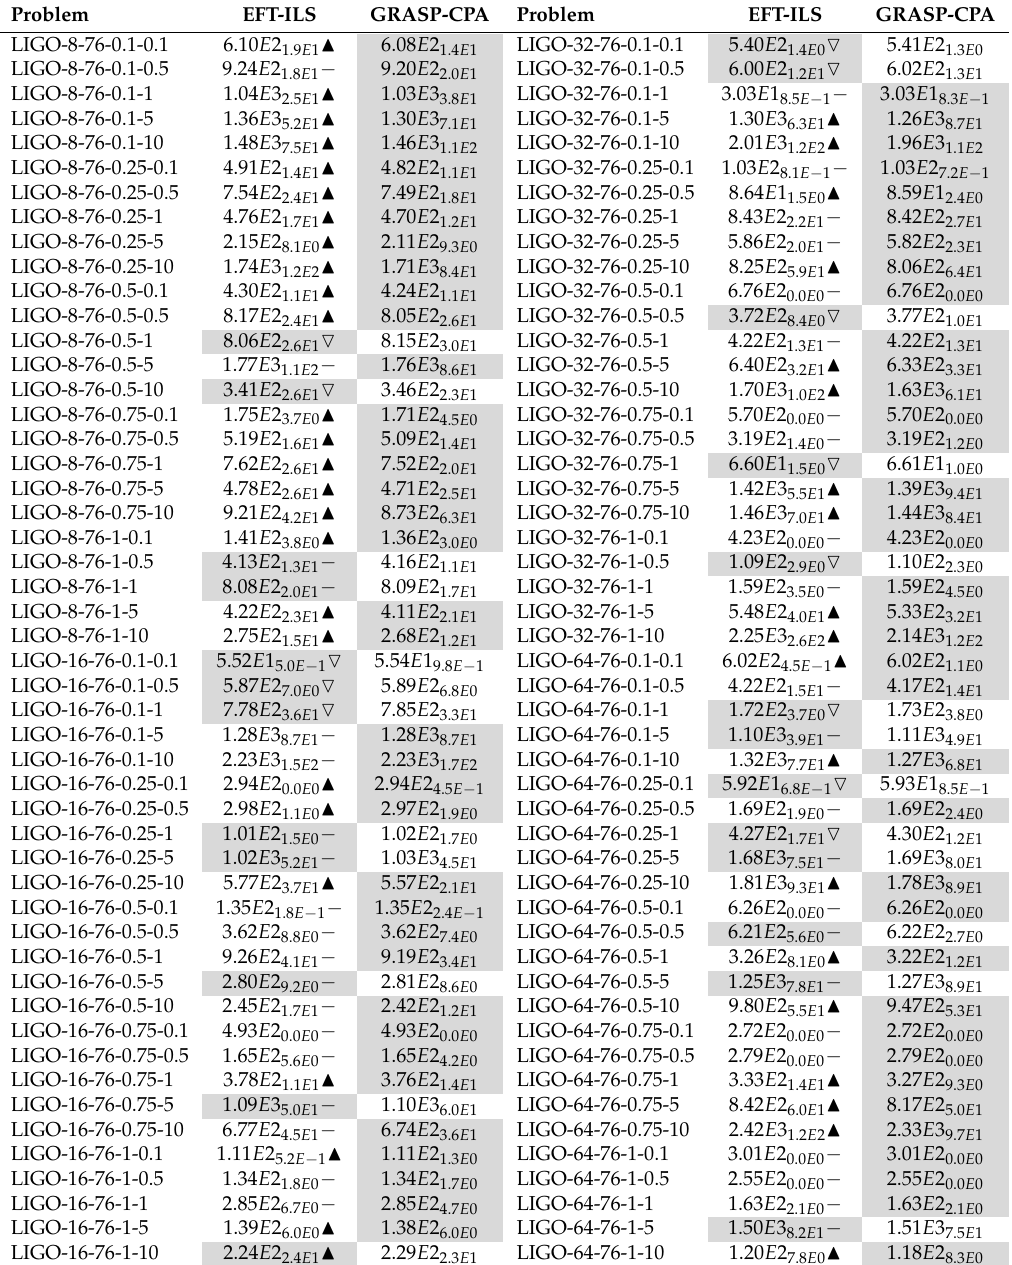
Table 5. LIGO instances median and IQR of EFT-ILS and GRASP-CPA over 100 independent runs. Light gray emphasizes the best results. Problem EFT-ILS GRASP-CPA GRASP-CPA